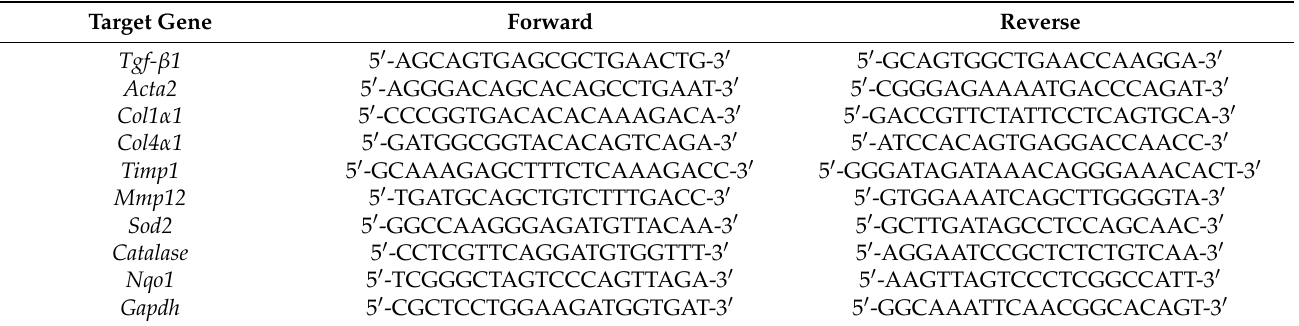
Table 1. Mouse primer for used qRT-PCR.